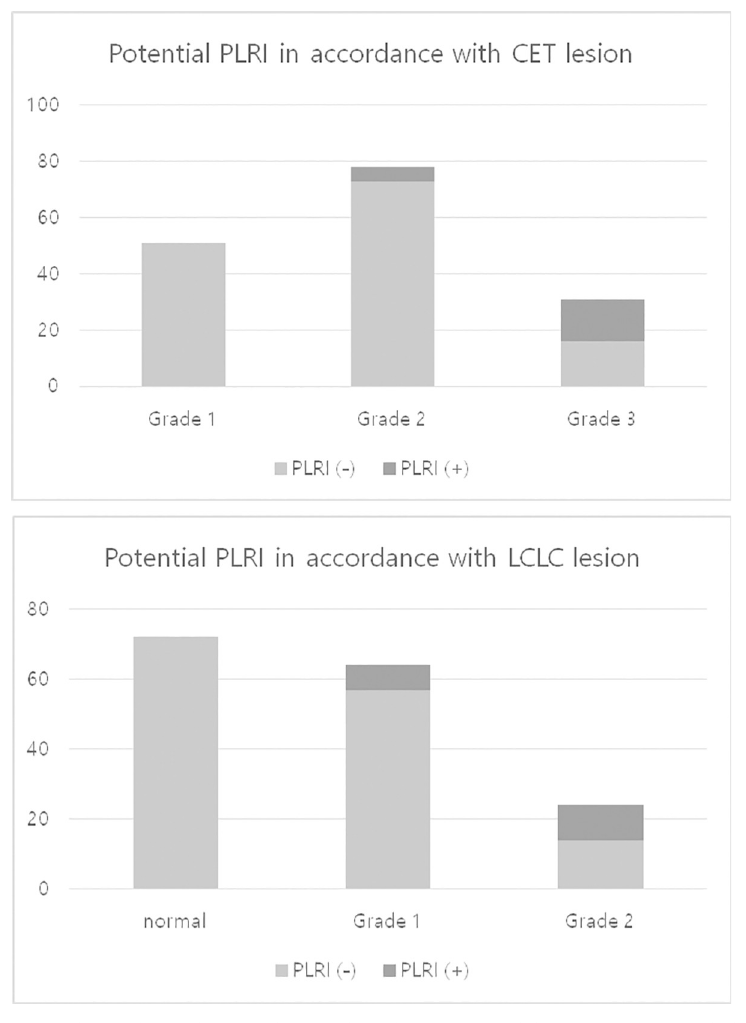
Fig 5. The incidence of potential posterolateral rotatory instability in accordance with the severity of the magnetic resonance imaging parameters. PLRI, Posterolateral Rotatory Instability; CET, Common Extensor Tendon; LCLC, Lateral Collateral Ligament